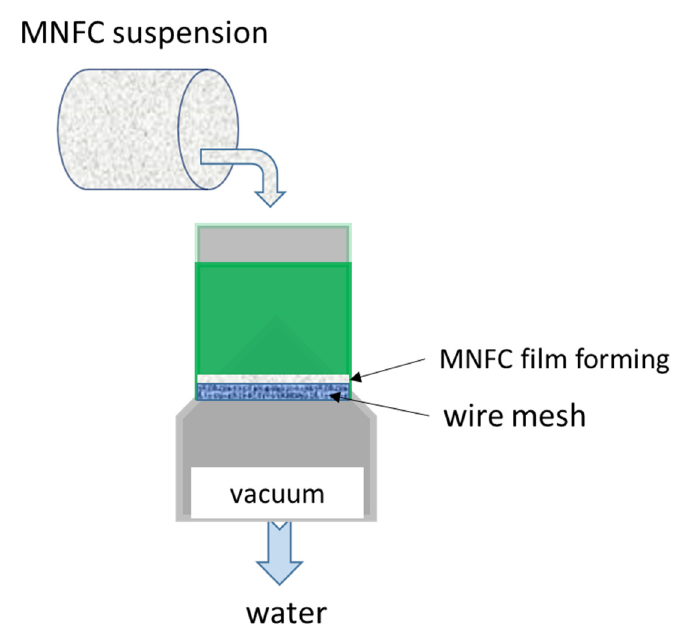
Figure 2. Schematic of MNFC film preparation on a laboratory sheet former adopting a polyamide filament screen put over the 125 µ m mesh to prevent nanofibrils draining with flushed water.